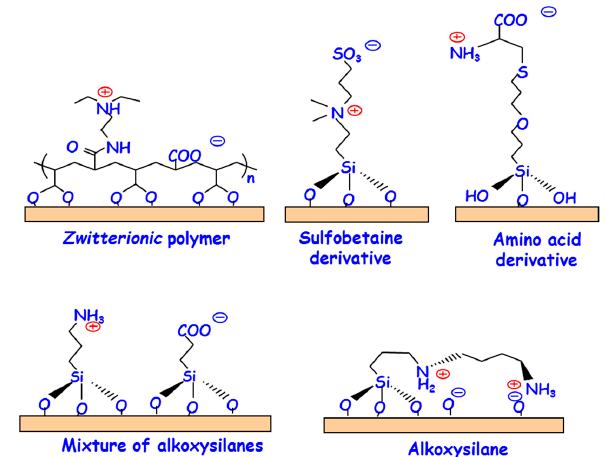
Figure 3. Representative examples of the different chemical strategies developed so far for the zwitterionization of biomaterials: Grafting of zwitterionic polymers [e.g., 3-(diethylamino)propylamine (DEAPA) coupled to poly(acrylic acid) (PAA)]; Sulfobetaine siloxane derivatives; Amino acid derivatives (e.g., cysteine); Mixture of alkoxysilanes [e.g., 3-aminopropyltrimethoxysilane (APTES) and carboxyethylsilanetriol sodium salt (CES)]; Alkoxysilane [ N -(2-aminoethyl)-3-aminopropyl- trimethoxysilane)